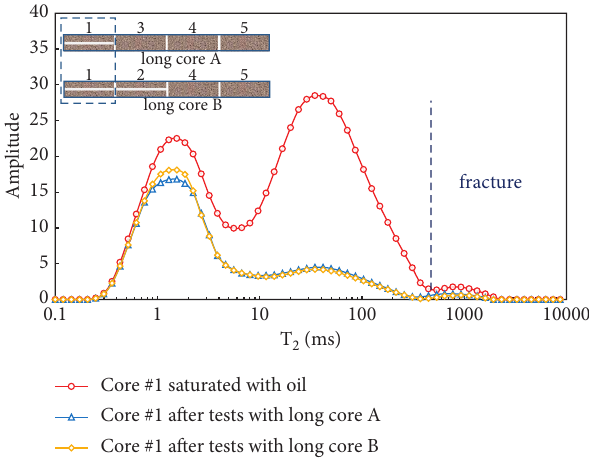
Figure 7: The difference between remaining oil distributions of core #1 after huff-and-puff tests with long core A and long core B.